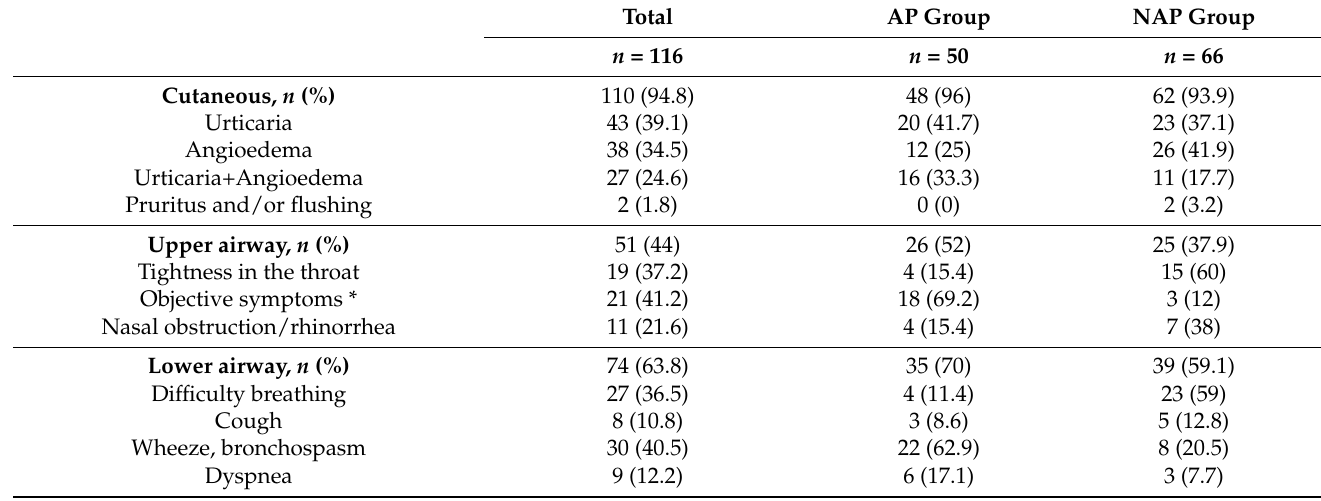
Table 3. Symptoms related to anaphylaxis in 116 pediatric patients referred to the PED. AP = acute patients, NAP = non-acute patients. * Objective symptoms or upper airway compromise: swelling of tongue, swelling/tightness in the throat, difficulty swallowing, hoarse voice, stridor. ** Tachycardia and hypotension defined according to age [12]. In the NAP group, cardiovascular and respiratory symptoms had mostly disappeared at the arrival to the PED and were reported by the patient and/or caregiver.